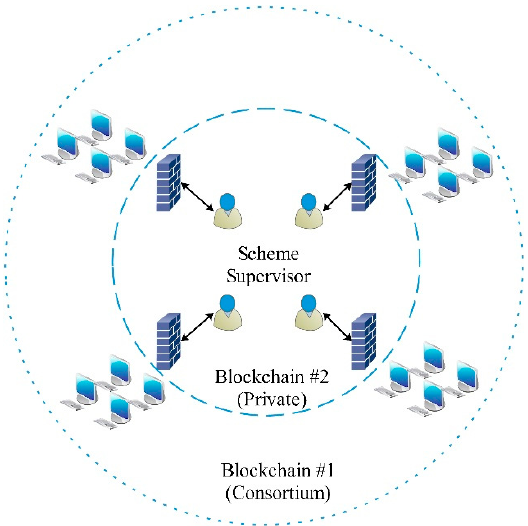
Figure 3. The proposed blockchain architecture.